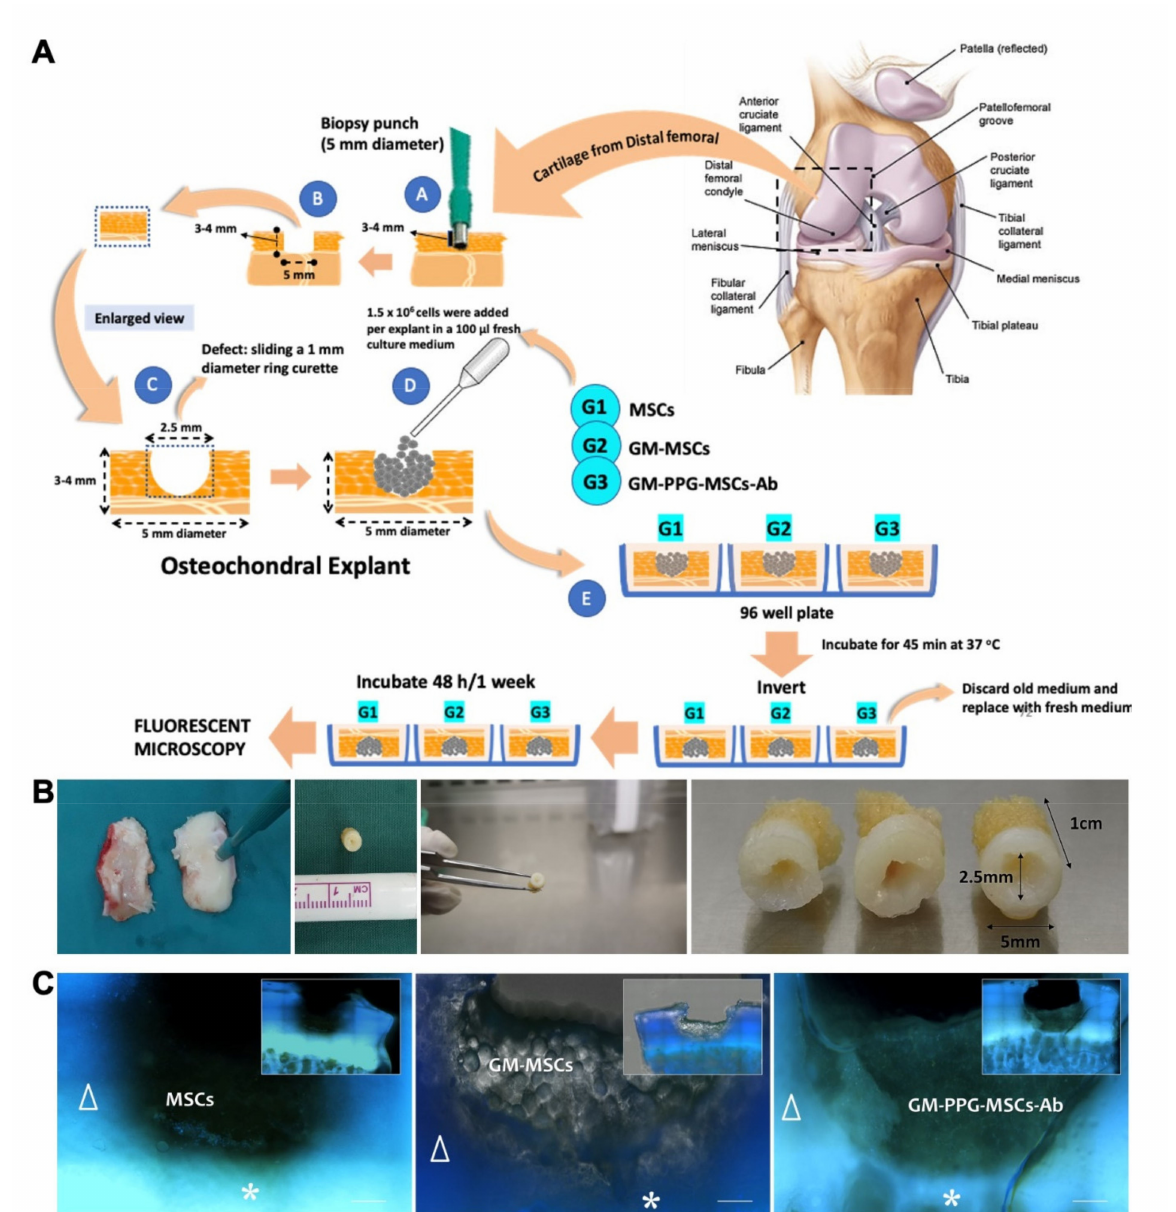
Figure 7. Preliminary assessment on articular cartilage explant. ( A ) Diagram shows the design flow of ex vivo implantation of MSCs, GM and GM-PPG-MSCs-Ab to osteochondral explant. ( B ) Figures showing the osteochondral explants. The explants were harvested using 5-mm punch biopsy producing a 1 × 0.25 × 0.5 cm in dimension ( C ) Immunofluorescence images of osteochondral explants incorporated with MSCs, GM-MSCs and GM-PPG-MSCs-Ab. Scale bar measure 300 μm. △ —osteochondral explant, ❈ —subchondral region.